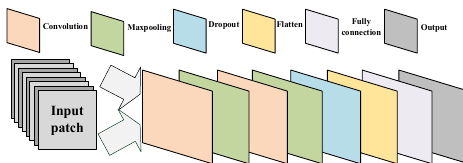
Figure 1. Architecture of the neural network.